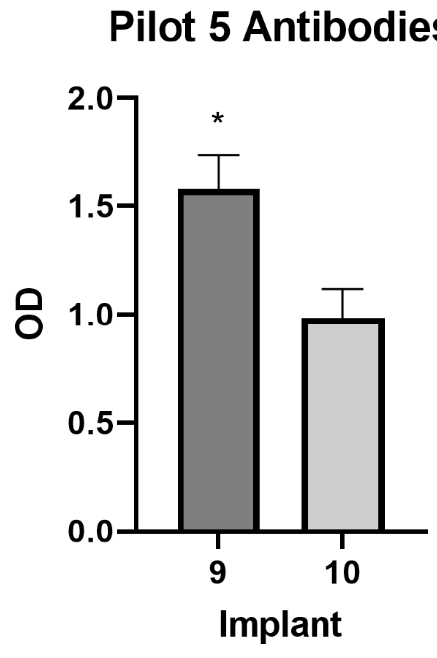
Figure 4. Differences in antibody production as measured on day 28 of Pilots 3 and 4. Implants not connected by asterisks (* or **) have significantly different ( p < 0.05) optical densities (OD), indicative of antibody concentration.